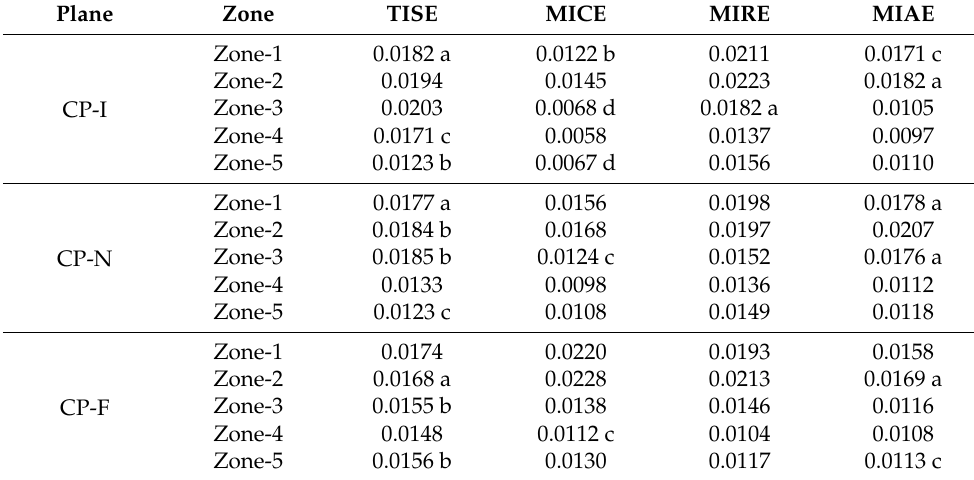
Table 2. Means of mass fractions of virus particles from five bird-occupied zones at three cross- sectional reference planes (CP-I, CP-N, and CP-F) in four models. Means annotated with the same letter indicate that NO statistically significant differences were found between them (ANOVA and subsequent Tukey’s test, p < 0.05).